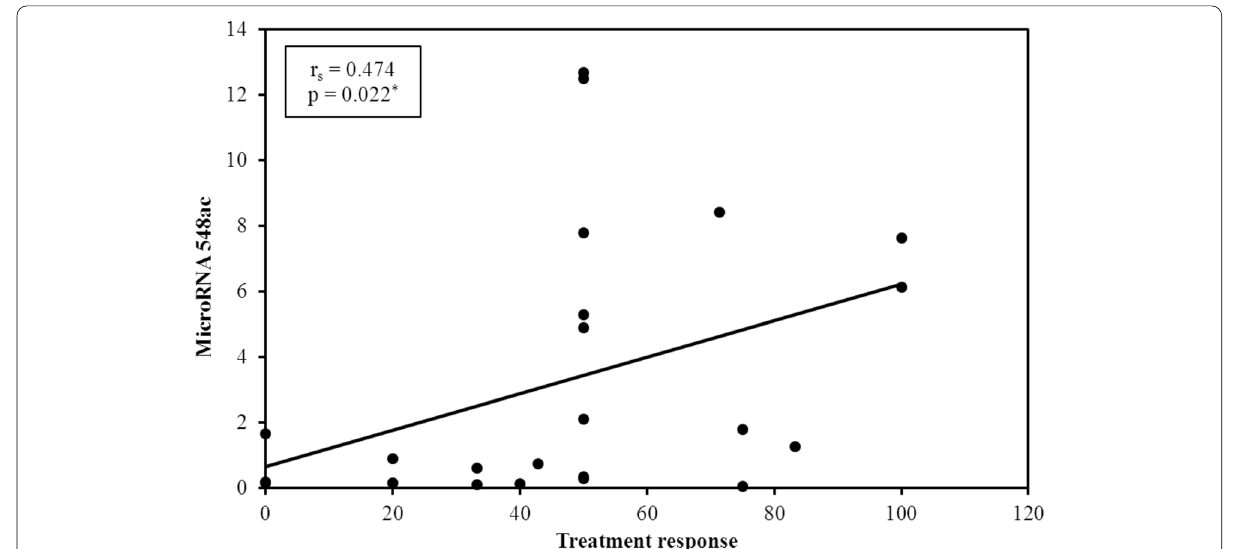
Fig. 2 Correlation between MicroRNA 548ac and treatment response in total